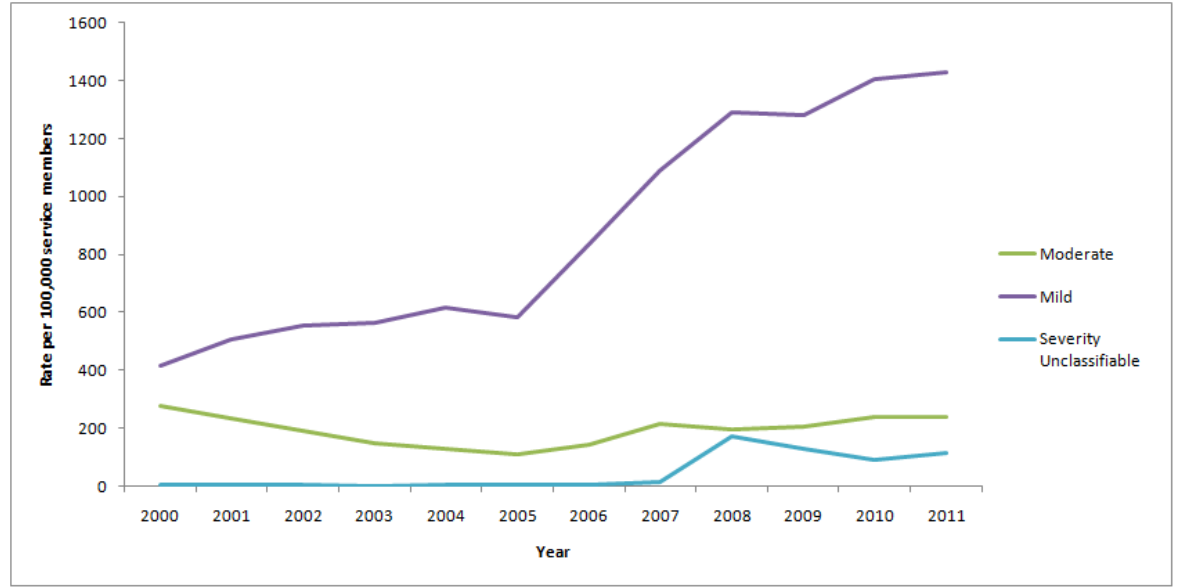
Figure 4. Estimated Annual Incidence Rates of Mild and Moderate TBIs and TBIs with Unclassifiable Severity Among Active-Duty U.S. Military Service Members, 2000 – 2011